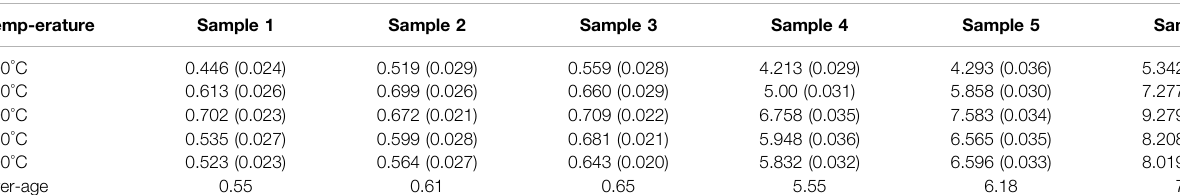
TABLE 7 | Thermal conductivity (W/(mK)) of different samples. Temp-erature